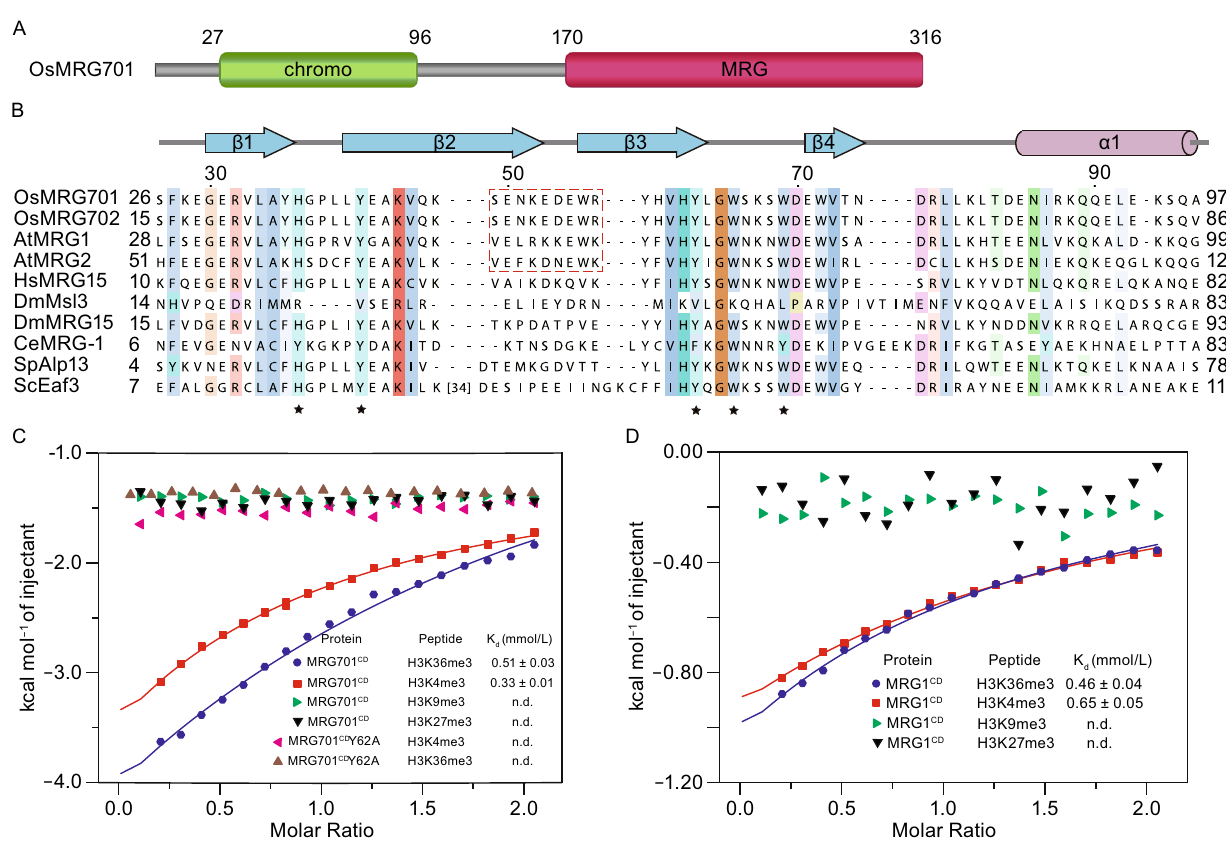
Figure 1. MRG701 CD speci fi cally interacts with H3K36me3 and H3K4me3 peptides in vitro . (A) Domain architecture of MRG701 in rice. (B) Sequence alignment of the chromodomains of MRG proteins in different species. Amino acids are shaded as a function of conservation with a 30% conservation visibility cutoff that was calculated using Clustal. Secondary structural elements of MRG701 CD are displayed above the sequence alignment. The conserved amino acids that represent the aromatic cage for histone peptide binding are marked with asterisks. The dimerization patch is indicated with a red dashed box. A large insertion that is only present in ScEaf3 is omitted for clarity and replaced by the number of amino acids. (C) ITC measurements of binding af fi nities of wild-type MRG701 CD and mutant MRG701 CD Y62A to tri-methylated histone peptides. (D) ITC measurements of binding af fi nities of MRG1 CD